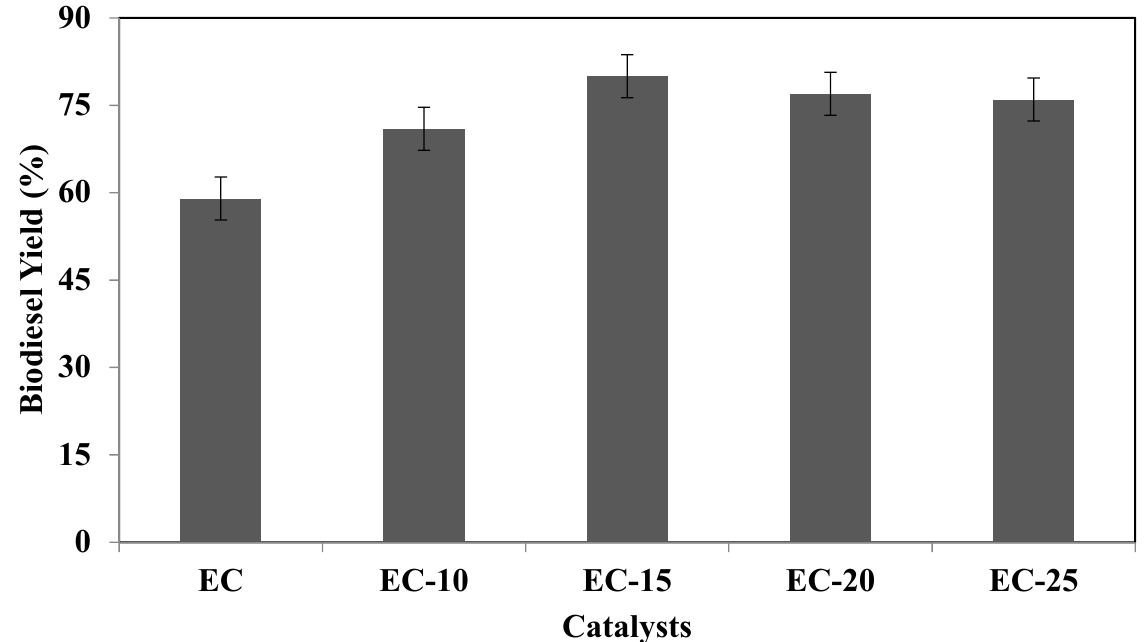
Figure 4. Catalyst evaluation selects the most suitable catalyst for transesterification to produce biodiesel (temperature—70 °C, oil-to-methanol molar ratio—6, time 60 min and catalyst loading—2 wt.%) among all the synthesised catalyst sam- ples.